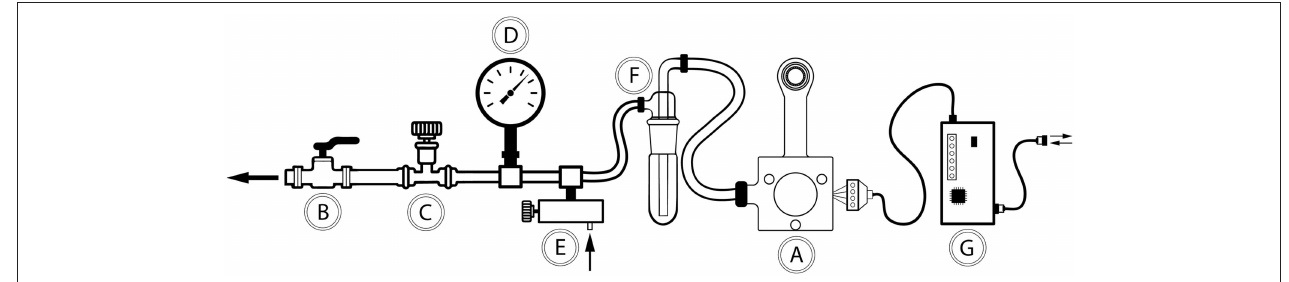
FIGURE 1 | Schematic drawing of the components in the vacuum window in vivo imaging platform. (A) Vacuum window, (B) connection to central vacuum system (ON/OFF), (C) coarse vacuum adjustment valve, (D) negative pressure gauge, (E) vacuum wastegate for fine tuning of negative pressure, (F) vacuum trap, (G) Arduino